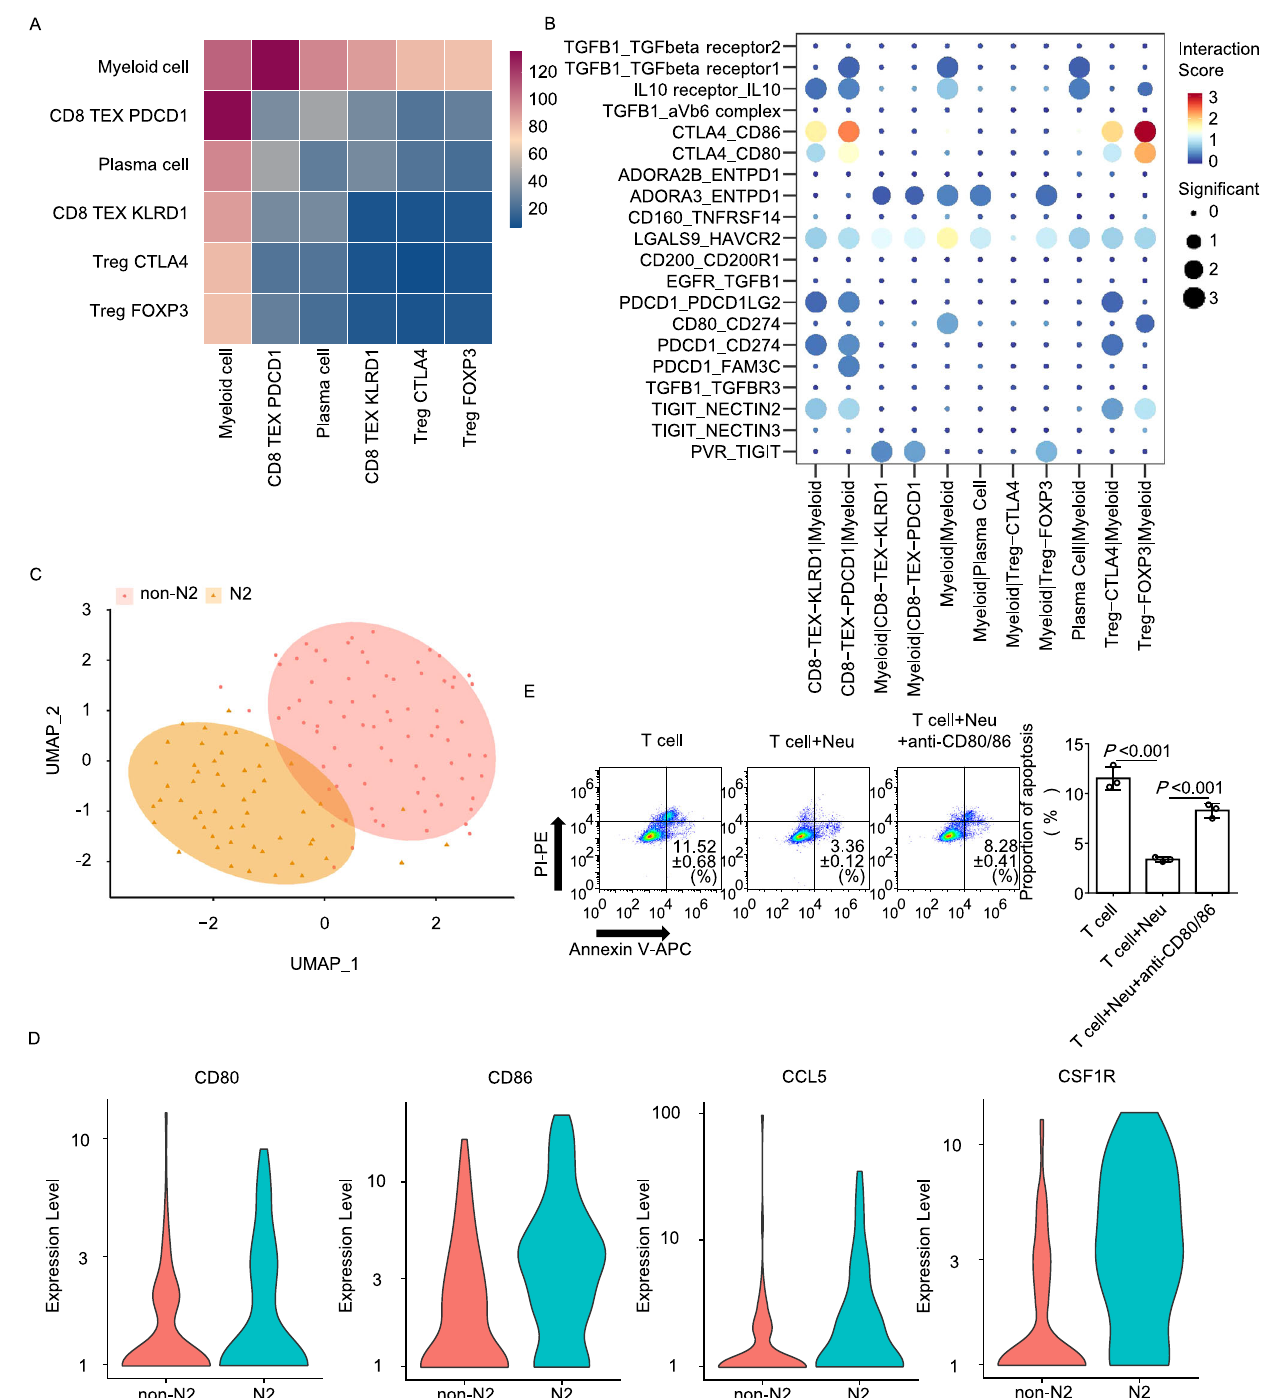
Fig.3|Single-cellsequencingrevealsaninhibitoryroleofneutrophilsintumor immune status through CD80/CD86-CTLA4 axis. A , B Interactions between subtypes of immune cells were analyzed. Functional phenotypes and predicted interactions of myeloid cells and T cells ( A ), and ligand-receptor interactions in immune checkpoints between immune cells are shown ( B ). C Myeloid cells were divided into 2 clusters (N2 and non-N2) using a UMAP plot. D The expression level of CD80,CD86,CCL5 and CSF1R inN2andnon-N2clusterisshown. E MurineTcells, T cells pre-stimulated with neutrophils, T cells pre-stimulated with neutrophils in